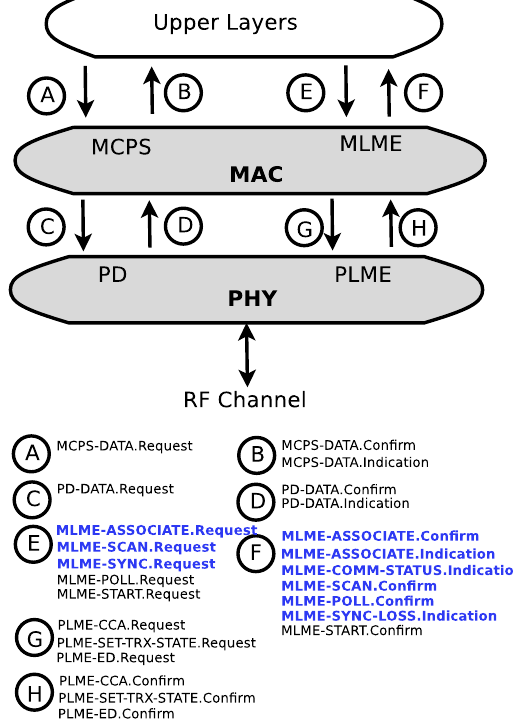
Figure 3. Ns-3 IEEE 802.15.4 layers and its